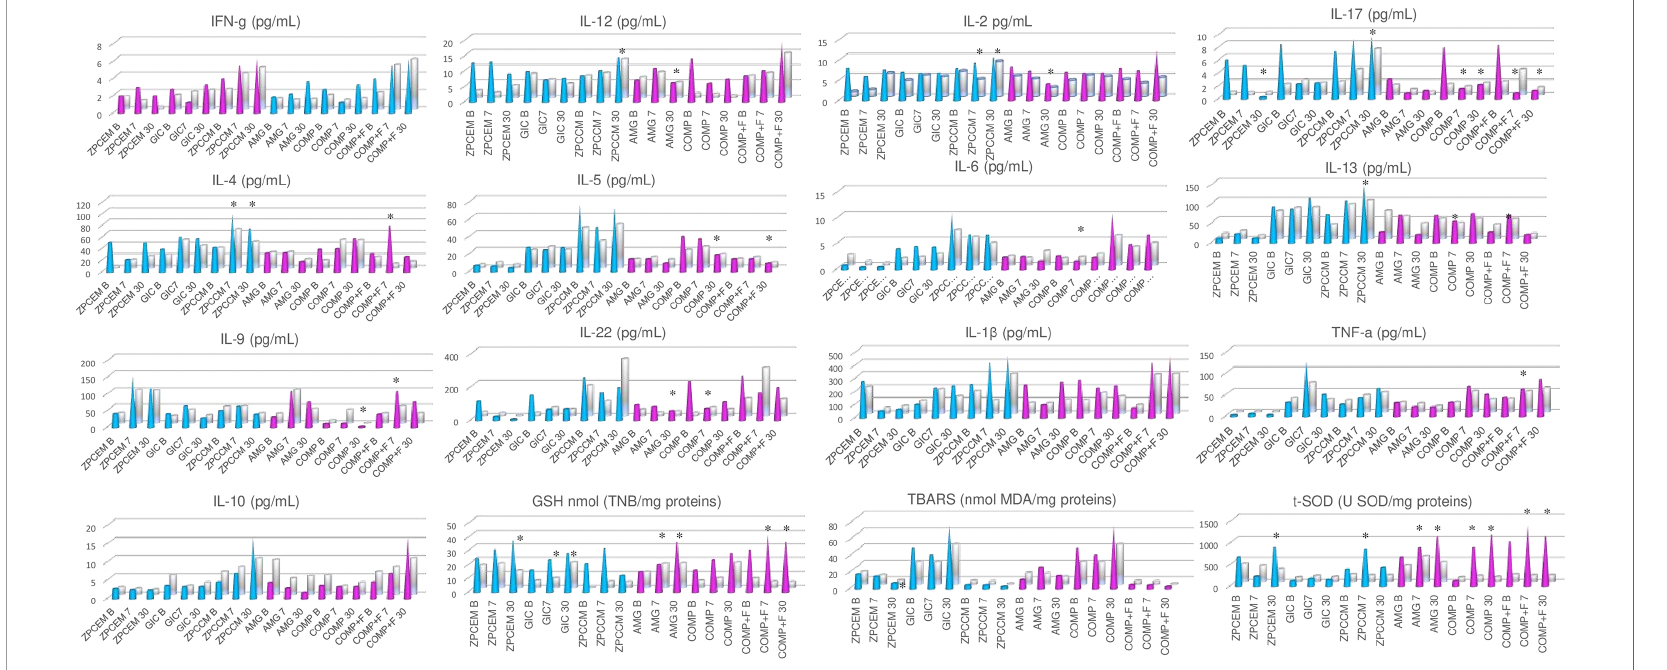
FIGURE 3 | Biomarker levels between different restorative materials 7 and 30 days post-restoration. ZPCCM exhibited remarkably increased values of Th1 (IFN g and IL-2; p < 0.05), Th2 (IL-4, IL-5, Il-6 and IL-13 p < 0.05), Th13 (IL-13; p = 0.045), and Th17 (IL-17; p = 0.021) markers. ZPCCM and COMP+F exhibited signi fi cantly elevated levels of IL-4 that were signi fi cantly higher compared to ZPCEM and COMP (p < 0.05), and for all other permanent fi llings, respectively. The highest GSH levels were demonstrated for reduced form of glutathione (GSH) in ZPCEM and COMP+F, for superoxide dismutase (SOD) in COMP and COMP+F, and for thiobarbituric acid reactive substances (TBARS) in GIC that simultaneously demonstrated signi fi cantly reduced SOD values compared to all permanent fi llings and ZPCEM (p < 0.05). D30 ZPCCM conserved signi fi cantly increased Th1(IL-1 and IL-2; p < 0.05), Th2 (Il-4, Il-5, IL-6; p < 0.05), Th13 (IL-13; p = 0.040), and Th17 (IL-17; p = 0.037) markers, while IL-22 was additionally increased in this timepoint (p = 0.021). Regarding in fl ammatory markers, GIC, ZPCEM, and AMG showed increased values of IL-13, IL-9, and IL-10, respectively (p < 0.05). ZPCEM, GIC, and COMP+F exhibited the highest GSH values (p < 0.05), GIC maintained the trend of the highest TBARS values (p = 0.001), while COMP and COMP+F exhibited the highest SOD values (p < 0.05). ZPCEM, zinc phosphate cement; GIC, glass ionomer cement; ZPCCM, zinc- polycarboxylate cement; AMG, amalgam; COMP-resin, COMP+F- fl uoride loaded resin; *p <